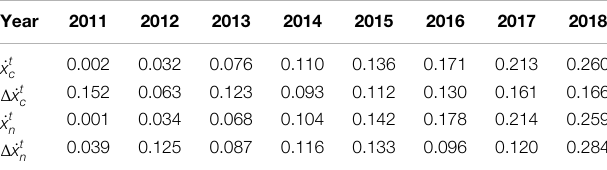
TABLE 6 | Annual comprehensive development levels of stock-increment resources in 2011 –